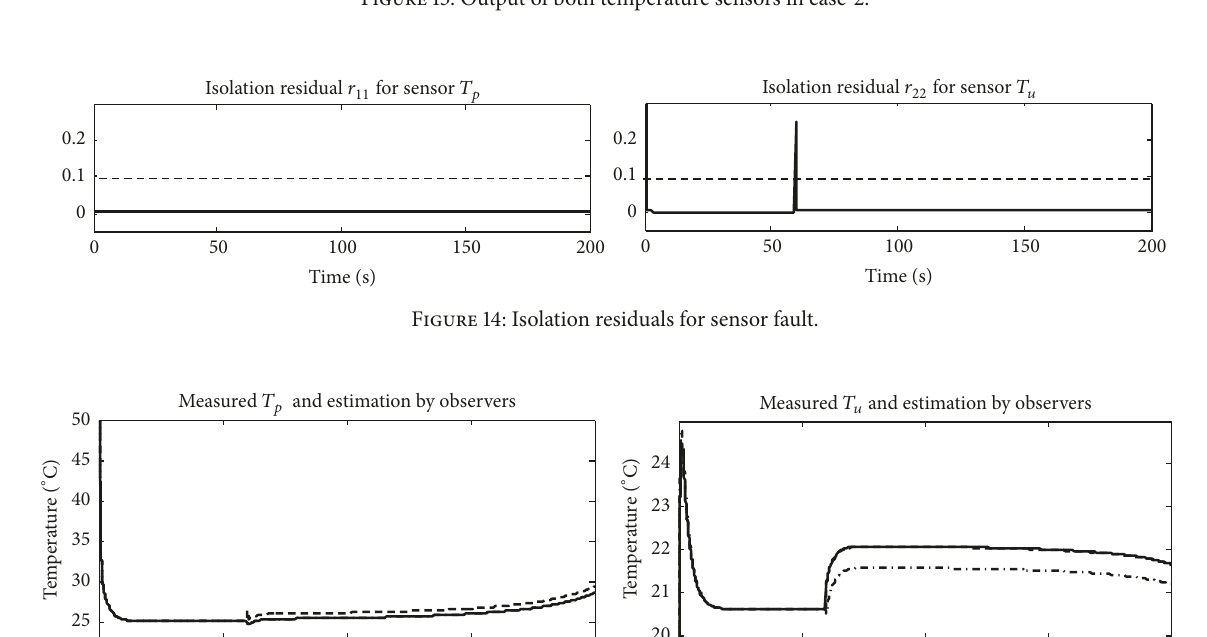
Figure 13: Output of both temperature sensors in case 2.